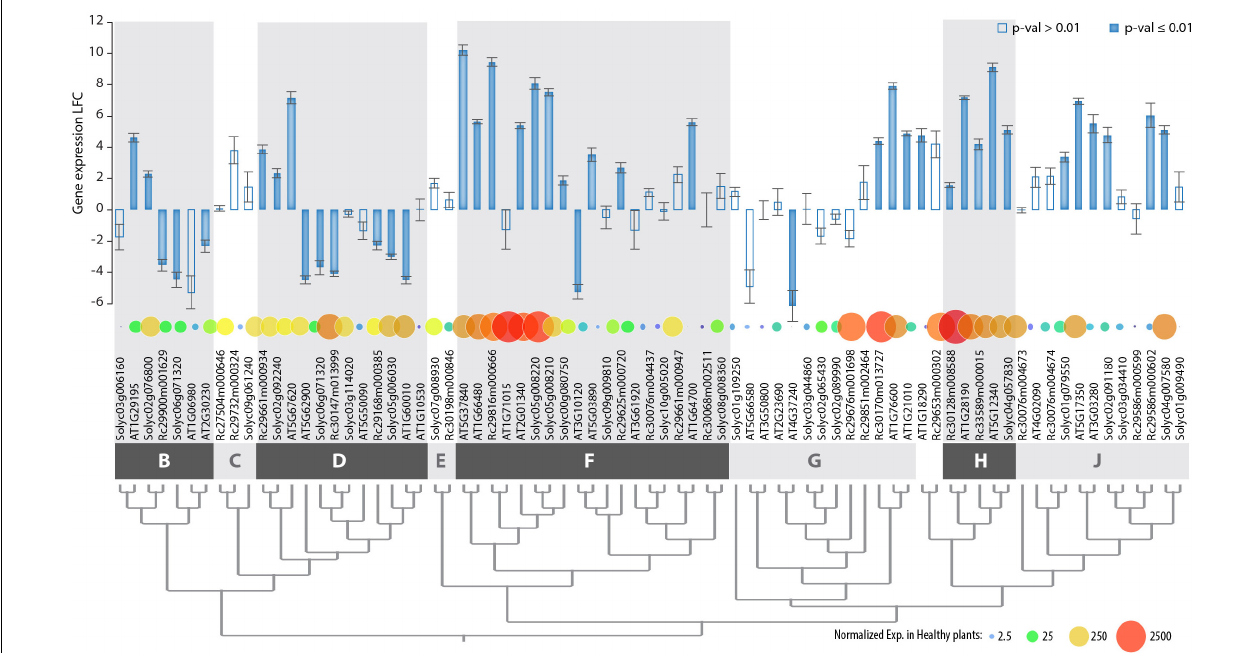
FIGURE 5 | Genome-wide expression of PADRE genes in Arabidopsis thaliana , Ricinus communis , and Solanum lycopersicum in response to S. sclerotiorum determined by RNA sequencing. Genes are ordered according to phylogenetic relationships shown in Figure 3, with phylogenetic groups delimited by dark and light gray boxes. Bar plot shows LFC of gene expression upon S. sclerotiorum inoculation, with error bars showing standard error for LFC over three independent biological experiments. Bars are filled when p -value for differential expression determined by DESeq2 analysis is ≤ 0.01, empty otherwise. Bubbles are sized and colored according to normalized gene expression in healthy plants. Exp., gene expression; LFC, log 2 fold change of gene expression. The associated raw data is available from GEO accessions GSE106811 and